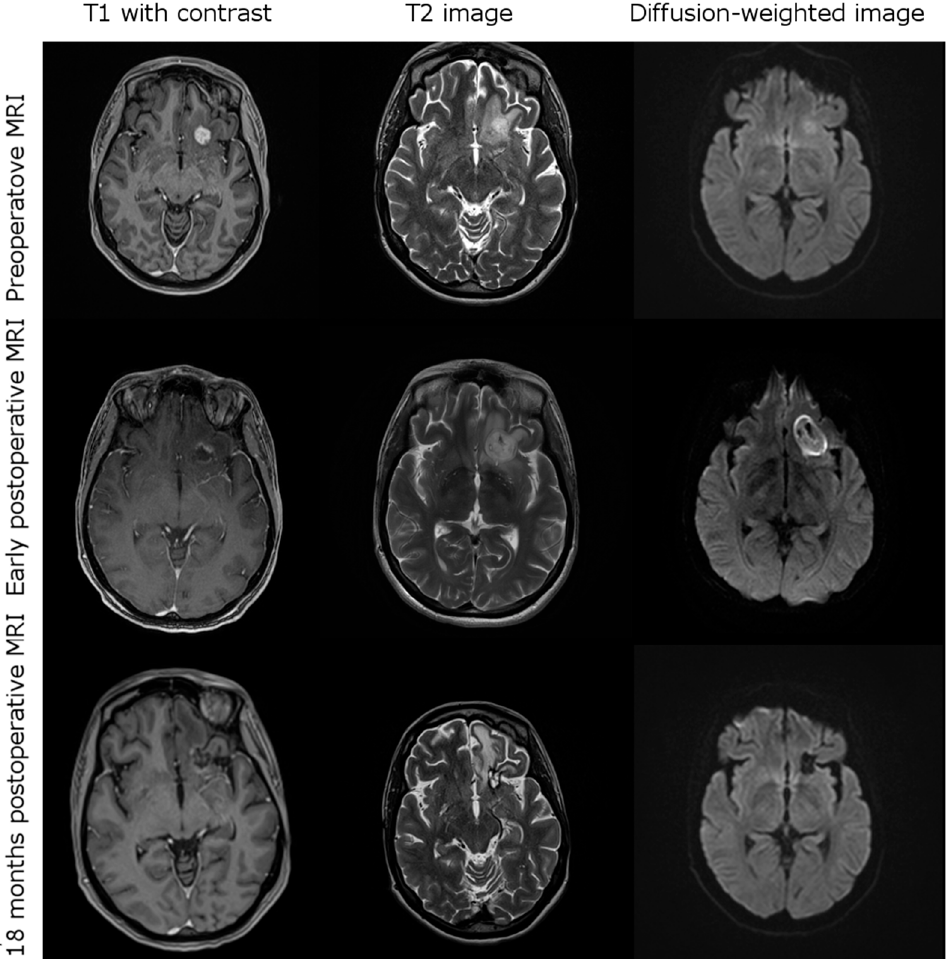
Figure 1. Exemplary case of a 41-year-old female patient suffering from a left frontal glioblastoma recurrence causing mild aphasia. Post-iPDT MRI showing characteristic changes such as disappearance of contrast enhancement, diffusion restriction within the treatment volume and mild perifocal